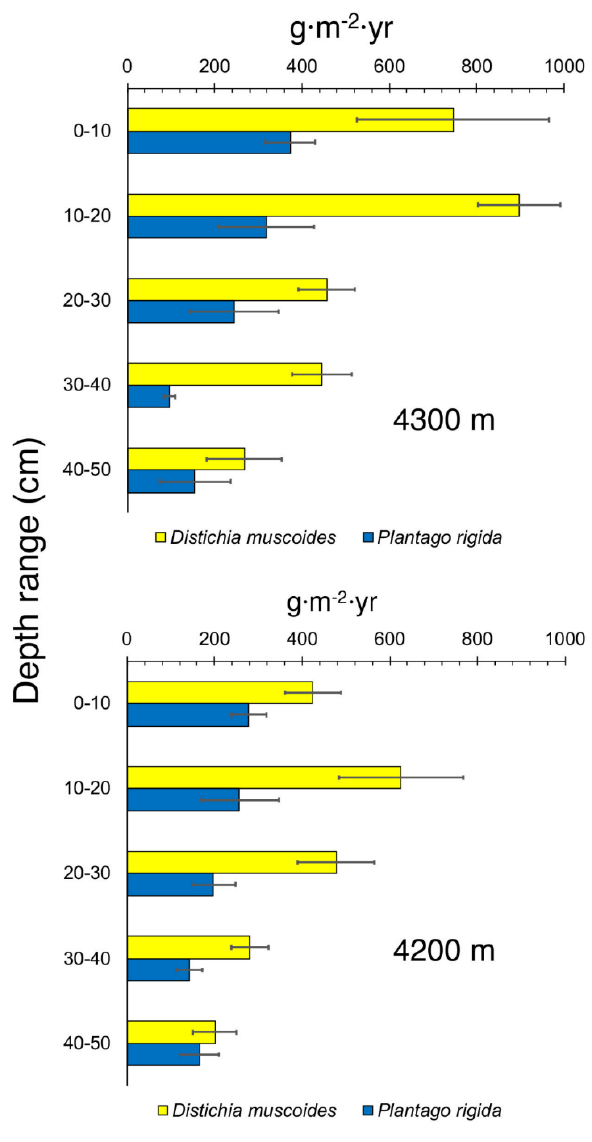
Figure 2. Patterns of root production in cushion plants of Distichia muscoides and Plantago rigida at two peatland sites at elevations of 4200 and 4300 m a.s.l. in the páramos of Northern Ecuador. Each bar represents the mean and standard error of nine